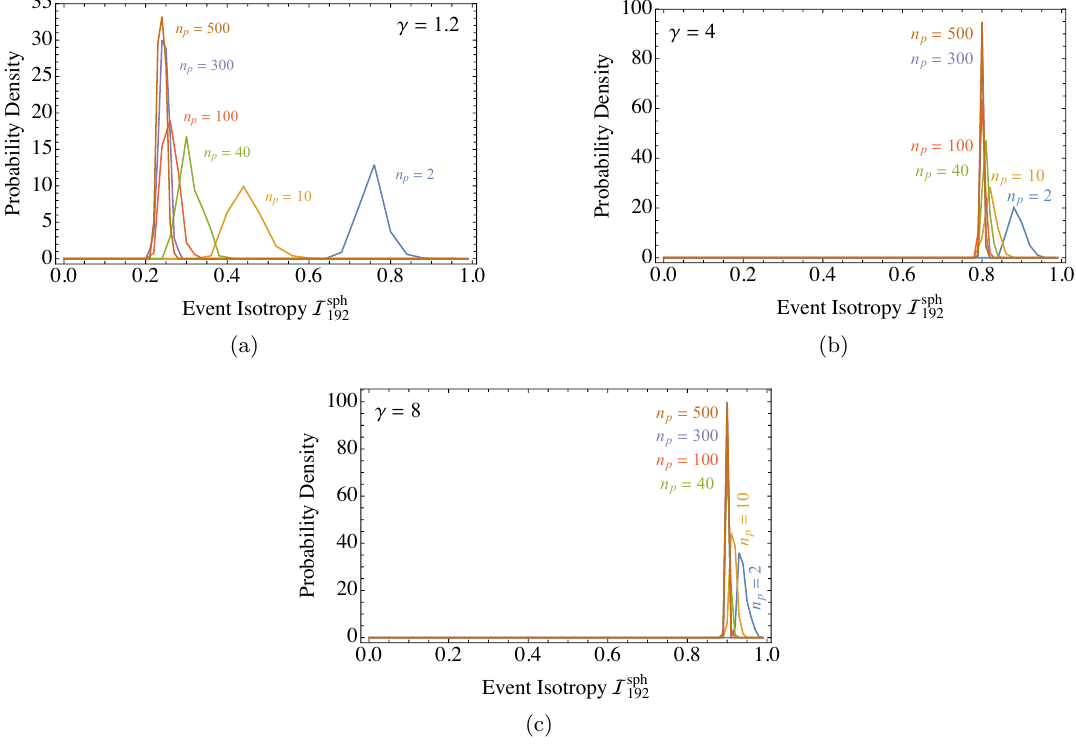
Figure 18 . Distributions in event isotropy I sph 100, 300, 500 at boost (a) γ = 1 . 2 , (b) γ = 4 , and (c) γ = 8 . As the boost increases, all of the distributions are shifted towards jettier values of event isotropy ( I sph If I vanishes, which occurs when ν +